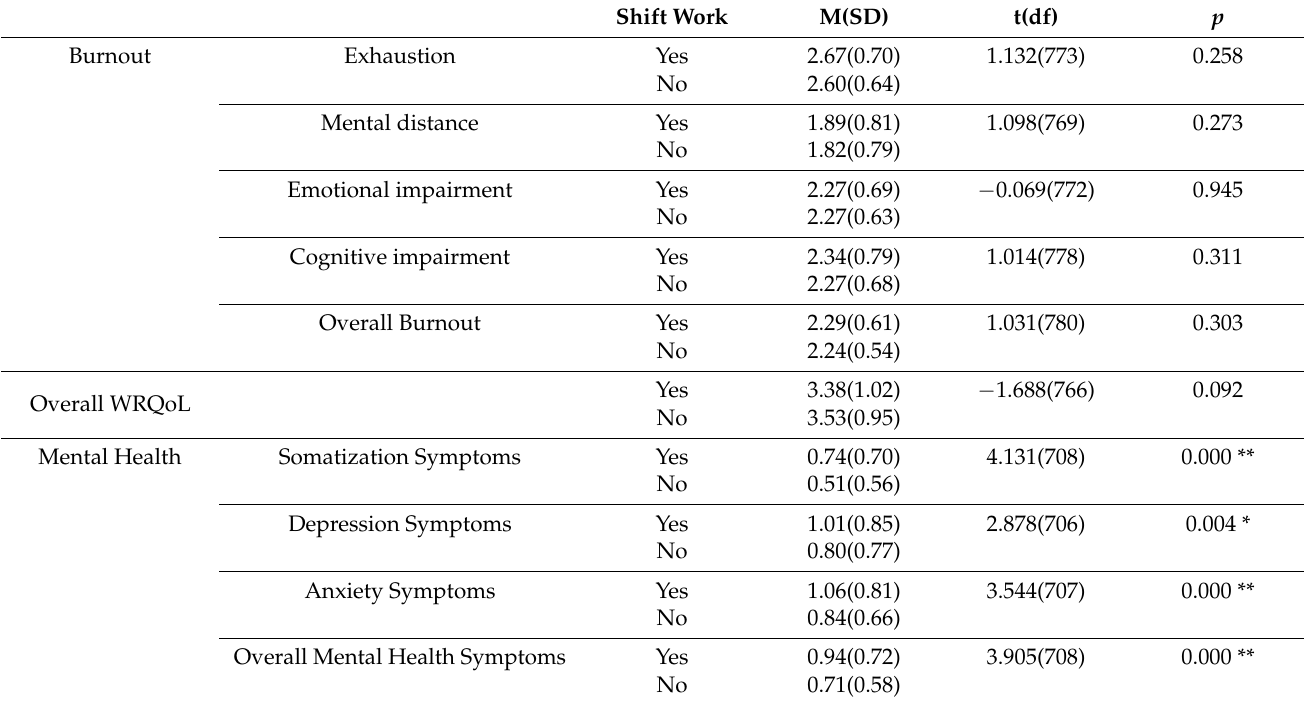
Table 3. Results for Burnout, Overall Work-Related Quality of Life and Mental Health Symptoms by Shift